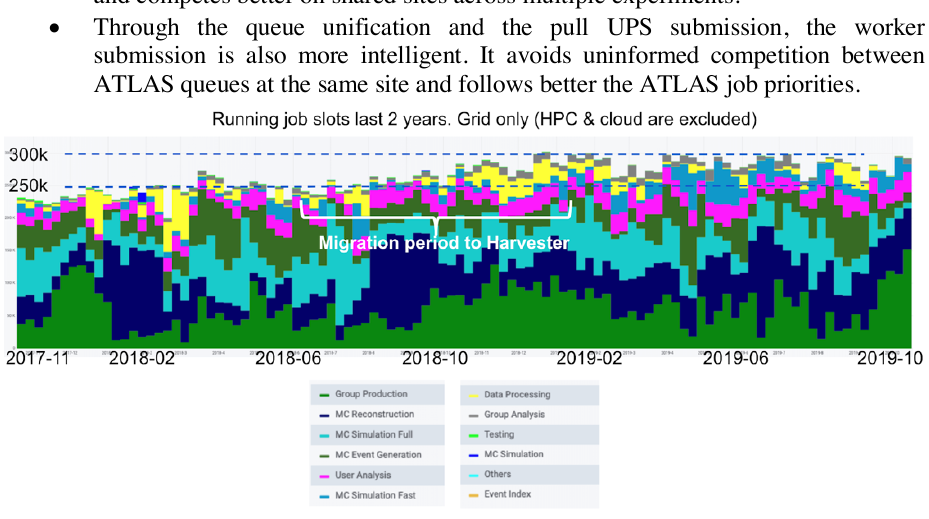
Fig. 3. Running job slots on Grid resources before and after the migration to Harvester